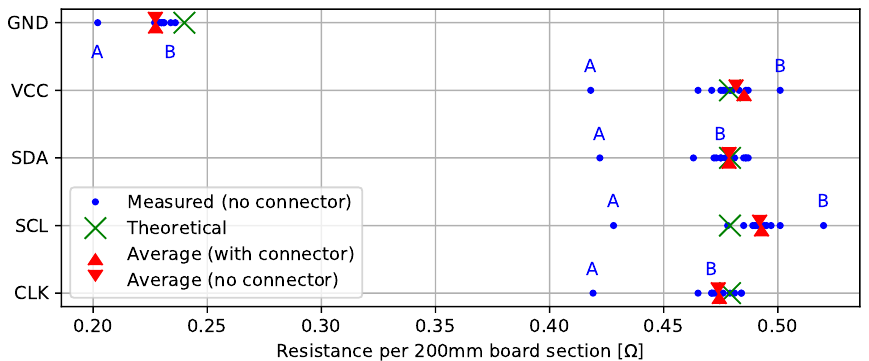
Figure 9. Trace resistance per 200 mm probe section, with and without connectors. Outlying trace resistance values for the same board are labeled as ‘A’ or